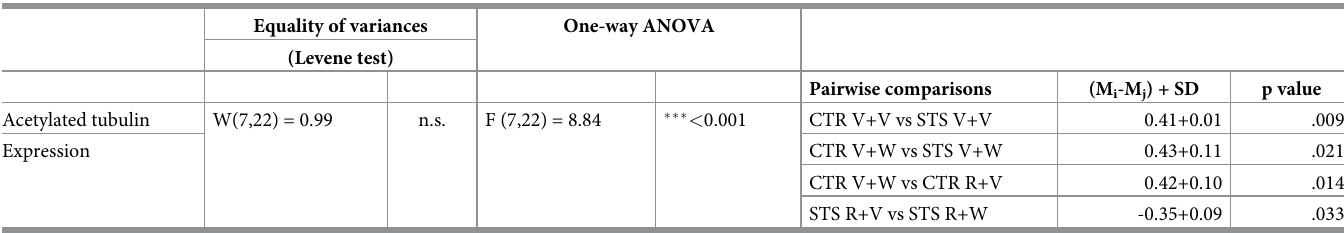
Table 1. Acetylated α -tubulin profile in the prefrontal cortex of control and stressed mice upon vehicle or cannabinoid drug exposure. Equality of variances One-way